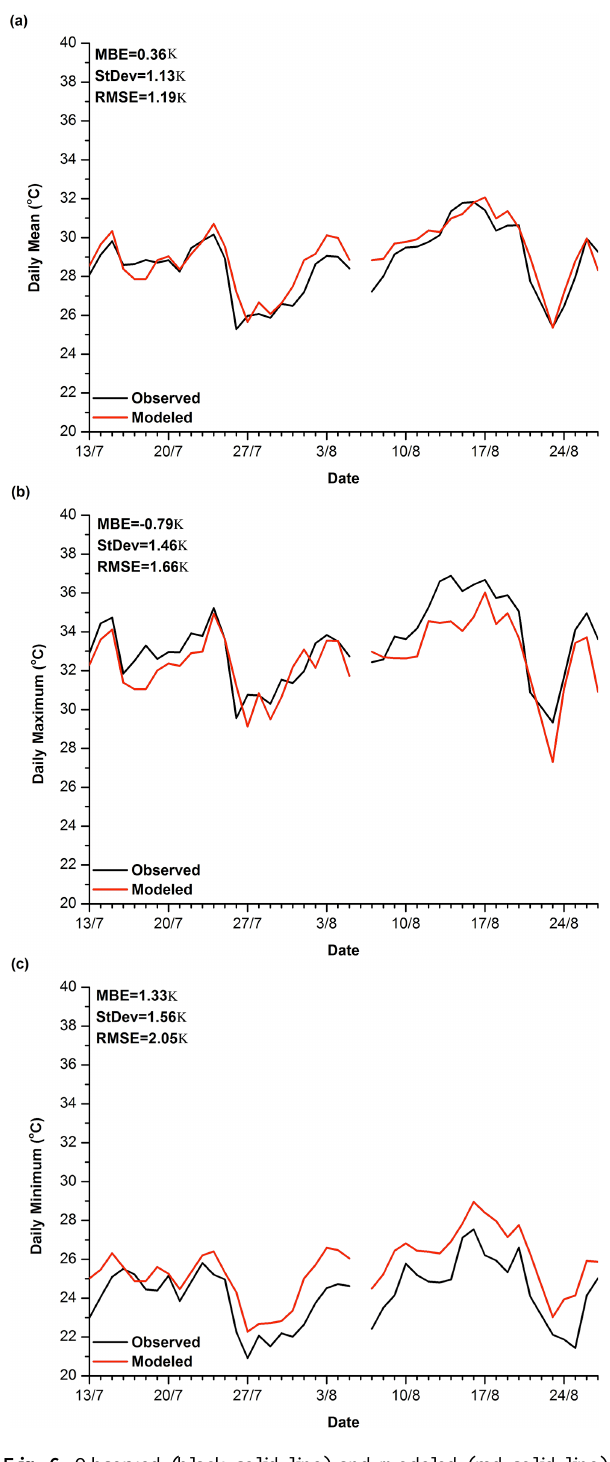
Fig. 6. Observed (black solid line) and modeled (red solid line) time series of the daily (a) mean, (b) maximum, and (c) minimum near-surface air temperature, averaged over all measurement sites. Statistical parameters are presented within the plots (MBE, RMSE, StDev: Standard